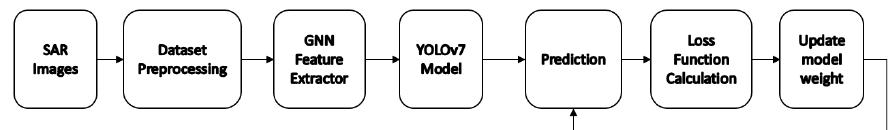
Figure 5. Flow diagram of the ship detection model . Figure 4. The YOLOv7 framework features a lead head and an auxiliary head that are guided by a label assigner [21].